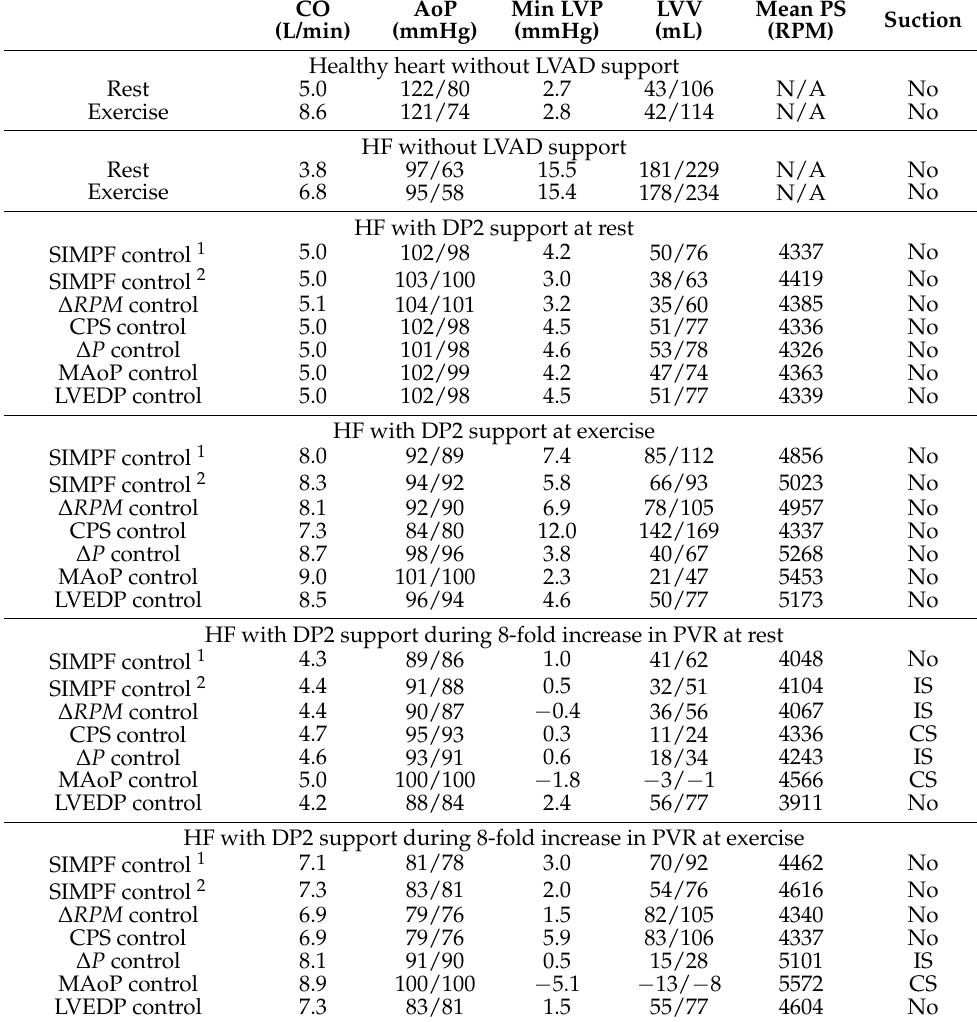
Figure 2. Measured pump flow signals were used to calculate SI , whose values gradually decreased and finally approached the setpoints of 9 for AFP ( a ) and 5 for DP2 ( b ), respectively. Table 1. Performance comparison among the proposed SIMPF control strategy and other control algorithms during various test conditions with AFP.